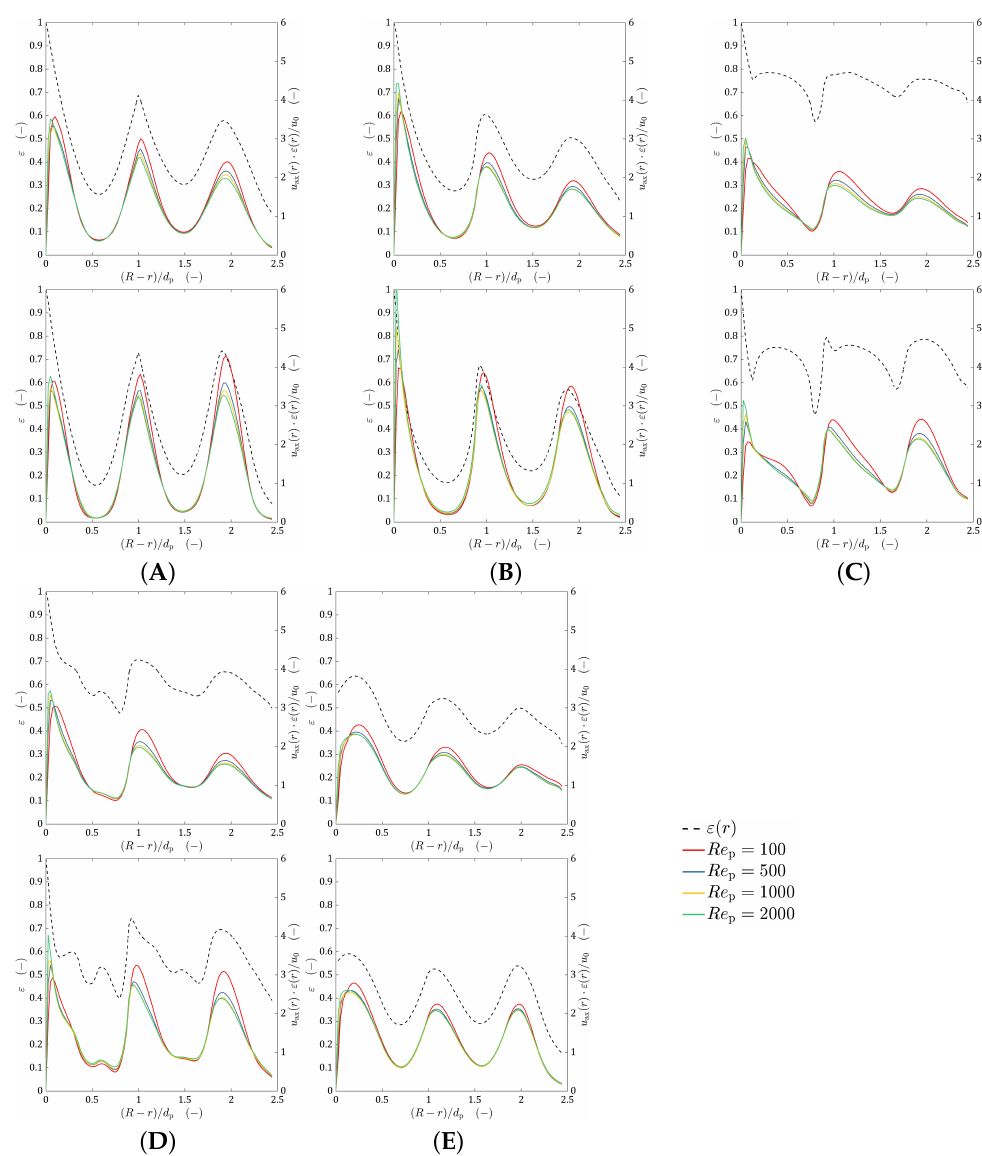
Figure 7. Radial void fraction profiles (dashed line) and radial profiles of the normalized averaged axial velocity (solid lines) for loose (top) and dense (bottom) packings of ( A ) spheres, ( B ) cylinders, ( C ) rings, ( D ) 4-hole cylinders, and ( E ) spheres with the wall